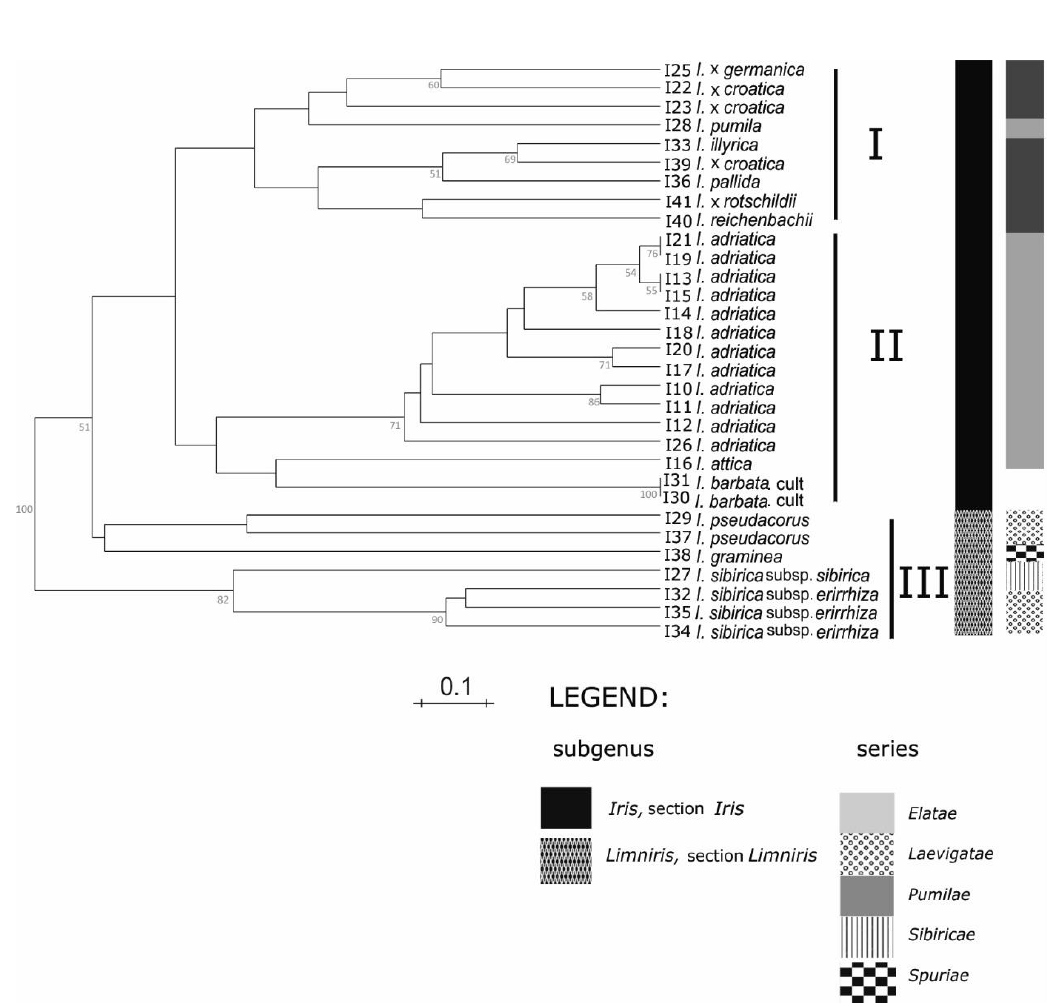
Figure 3. UPGMA dendrogram obtained with Dice’s similarity coefficient based on eight SSR markers for 31 out of 32 collected Iris samples (as explained in the Material and Methods section); Bootstrap percentages (>50) are shown in the nodes of the dendrogram; labels I–III denote major clusters.